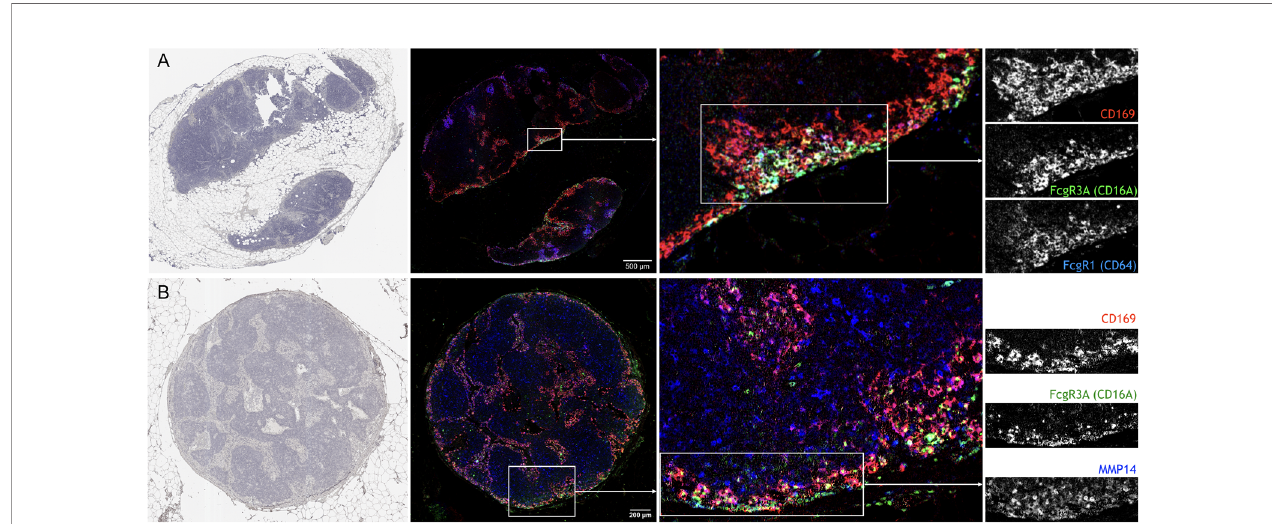
FIGURE 6 | Con fi rmation of novel SSM markers in regional lymph nodes from head and neck cancer patients with multiplex immunohistochemistry. (A) Sequential staining for Hematoxylin (left), CD169, CD16A and CD64 on same lymph node section shows the co-localization of the three markers. Of note, CD169+ macrophages in closer proximity to the sub-capsular sinus were also positive for CD16A and CD64. (B) Sequential staining for Hematoxylin (left), CD169, CD16A and MMP14 on same lymph node section shows the co-localization of the three markers. N = 2; Representative pictures are